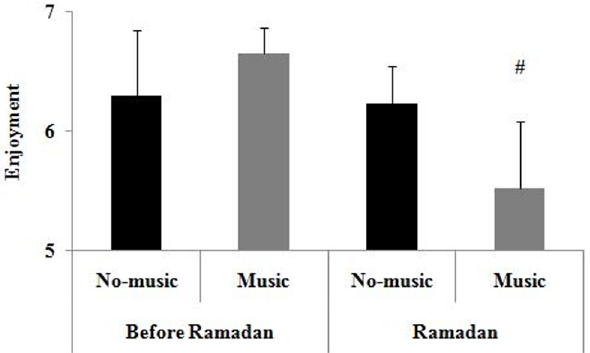
Fig 2. Means and standard deviations for enjoyment according to Music and Ramadan period conditions. On the y-axis, the number 1 represents the label “ not at all true ” , whereas the number 7 represents the label “ very true ” . #: significantly different compared to before Ramadan for the same music condition.